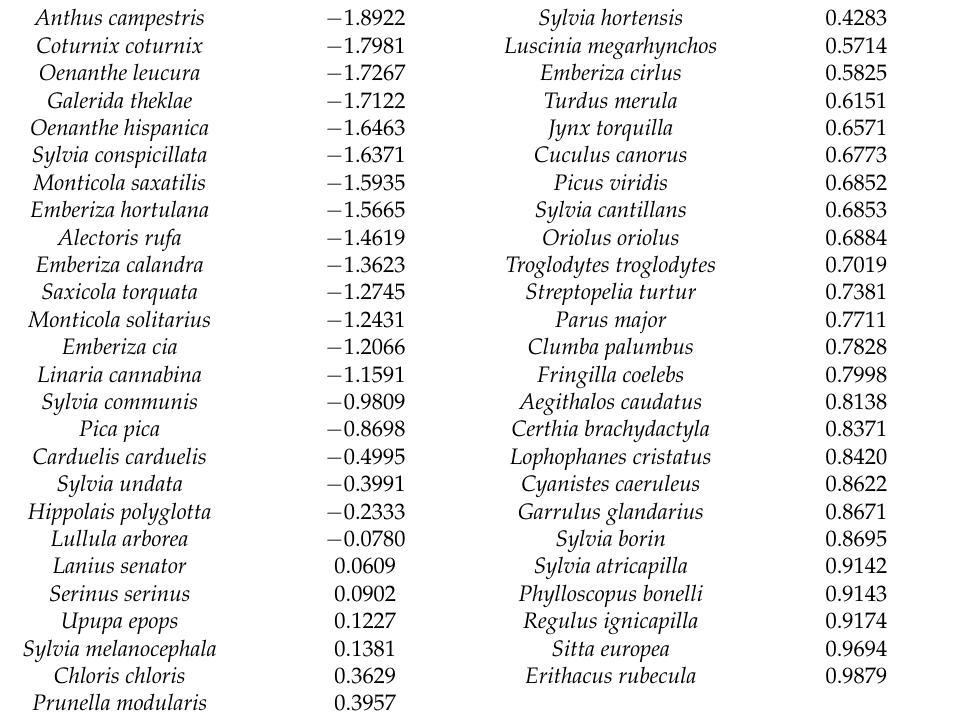
Table A1. Scores of the bird species on the first axis of correspondence analysis of the birds × sample